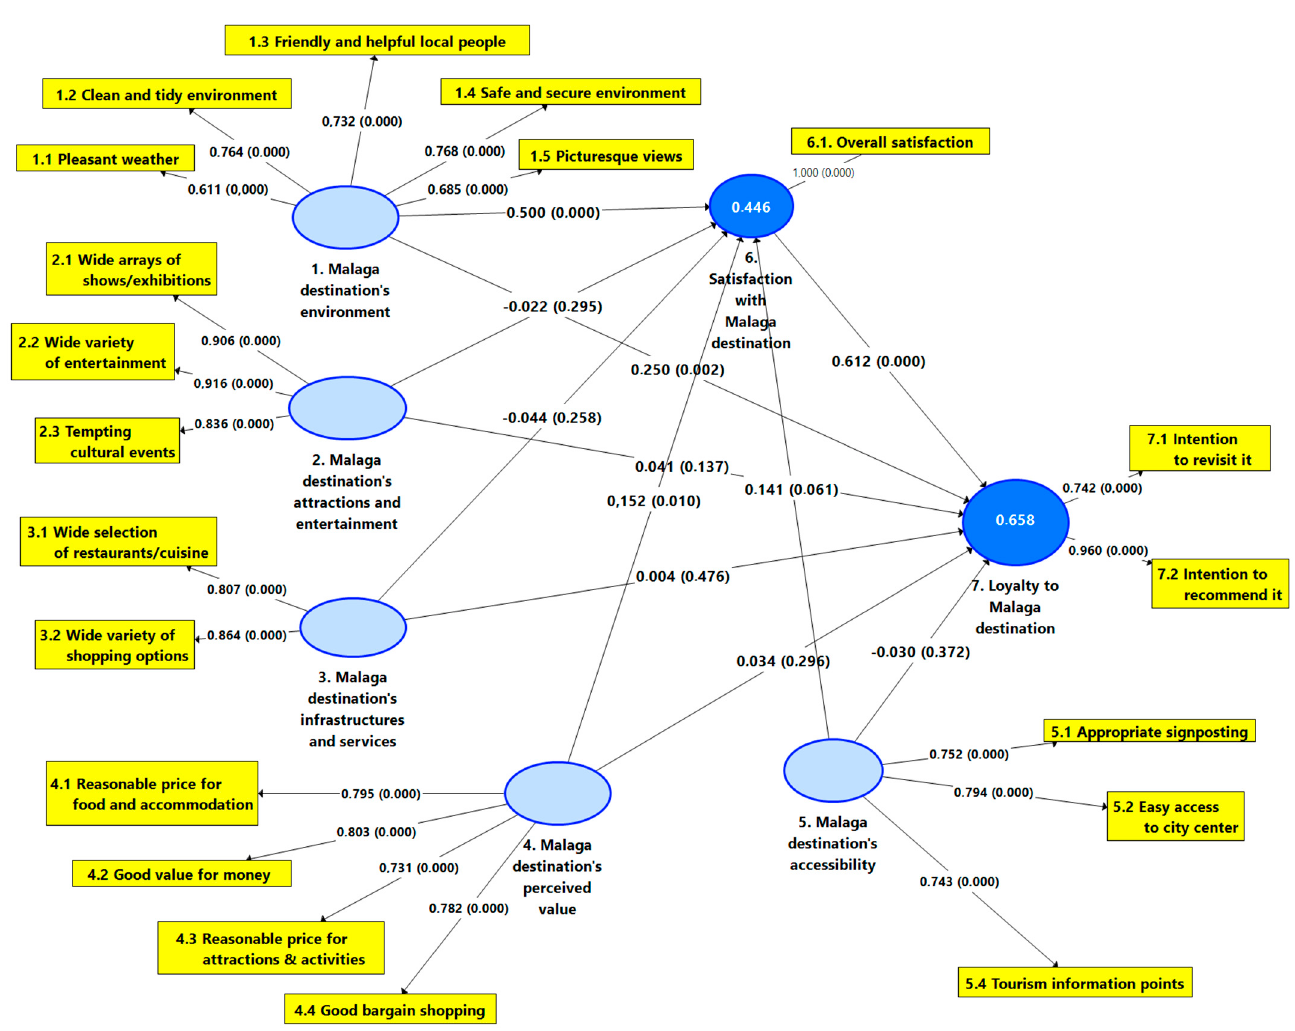
Figure 3. Tested model. Note: p-values in brackets. Source: Own elaboration from [140]. Table 8. Mediation analysis of satisfaction.